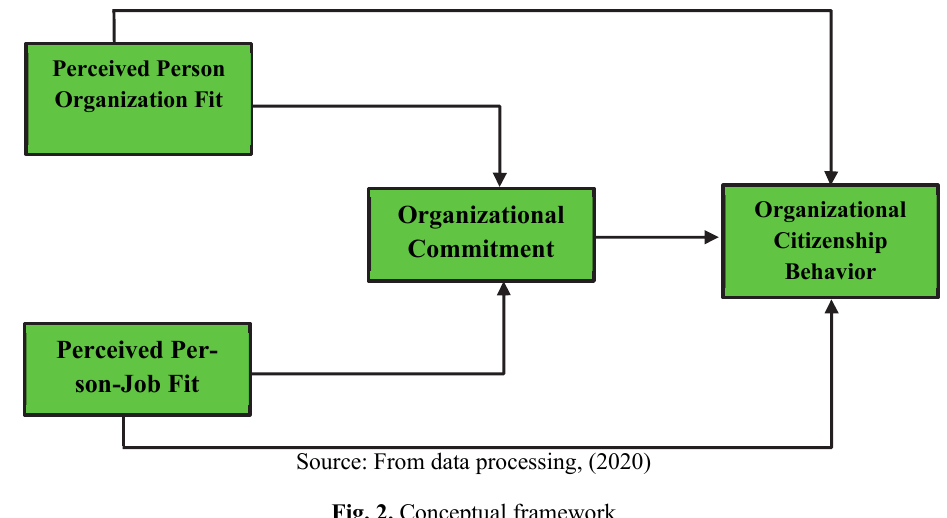
Fig. 2. Conceptual